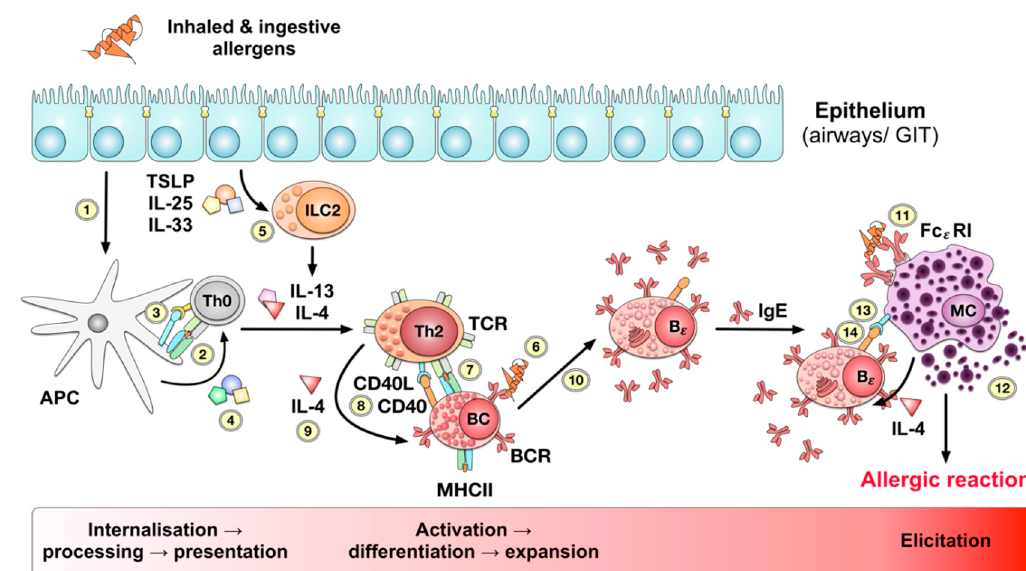
Figure 1. Pathomechanism of type I allergy. Uptake or penetration of allergen molecules via the respiratory or gastrointestinal epithelia (1) results in uptake, processing and presentation of allergen-derived peptides by antigen presenting cells (APCs, (2)). Activated APCs express co-stimulatory signals (3) and secrete cytokines (4) that promote the differentiation of naïve antigen-specific T cells into effector cells. In case of allergic reactions naive allergen-specific Th0 cells differentiate into Th2 cells orchestrated by the cytokines IL-13 and IL-4 produced by innate like lymphocytes type II (ILC2). The respective ILC2s are in turn activated by the cytokines thymic stromal lymphopoietin (TSLP), IL-25, and IL-33 secreted by either stressed or damaged epithelial cells (5). The activated allergen-specific Th2 cells in turn activate allergen-specific naïve B cells that have specifically recognized the allergen via their B cell receptor (BCR, (6)), taken up, processed, and presented the allergen to the T cell receptor (TCR) of the activated Th2 cell (7). The Th2 cell subsequently authorizes the activation and di ff erentiation of the allergen-specific B cell via CD40 and CD40 ligand (CD40L) signaling (8) and secretion of the Th2-promoting cytokine IL-4 (9). Together, these signals allow for the di ff erentiation of the allergen-specific B cell into an IgE-producing plasma cell (10). The allergen-specific IgE antibodies produced in turn by the activated plasma cell bind to the high a ffi nity IgE receptor Fc ε RI on the surface of mast cells, resulting in the sensitization of these cells (11). Upon second contact with the allergen the allergic reaction is triggered by the cross-linking of the surface bound IgE antibodies resulting in the degranulation of the mast cell associated with the release of large amounts of pro-inflammatory mediators (12). The activated mast cells in a positive feedback loop drive further activation of allergen-specific B cells by the production of IL-4 and providing CD40L-mediated co-stimulatory signals (13) to CD40 on the B cell surface